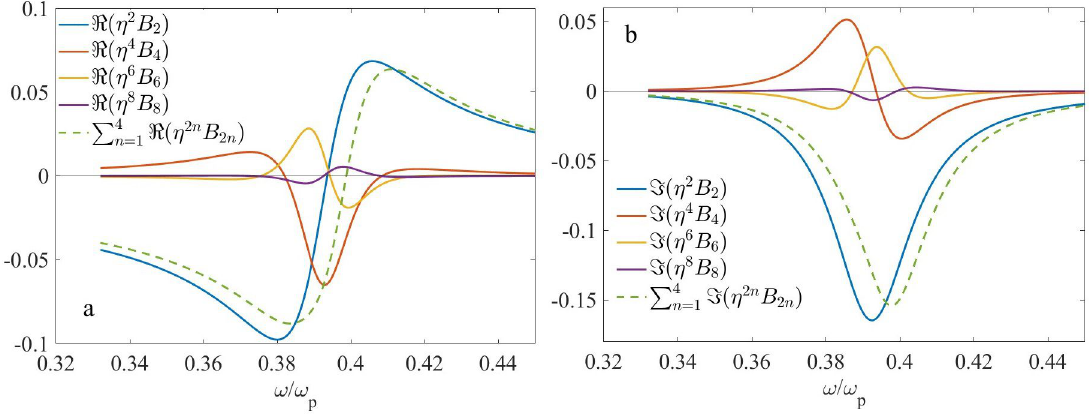
Figure 4. The same as Figure 3, but at f 1 = f 2 = 0.5. ( a ) (cid:60) ( η 2 n B 2 n ) and ( b ) (cid:61) ( η 2 n B 2 n )